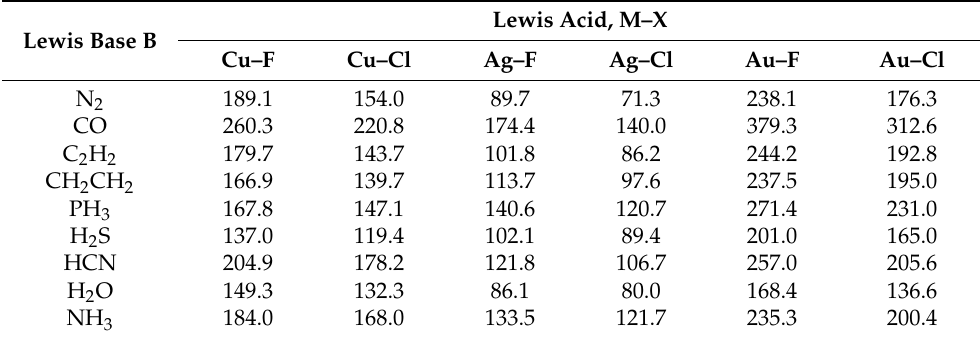
Table 2. Intermolecular stretching quadratic force constants k σ /(N m − 1 ) of complexes B · · · M–X calculated at the CCSD(T)/aug-cc-pVZ/aug-cc-pVTZ-PP level of theory (see text for the